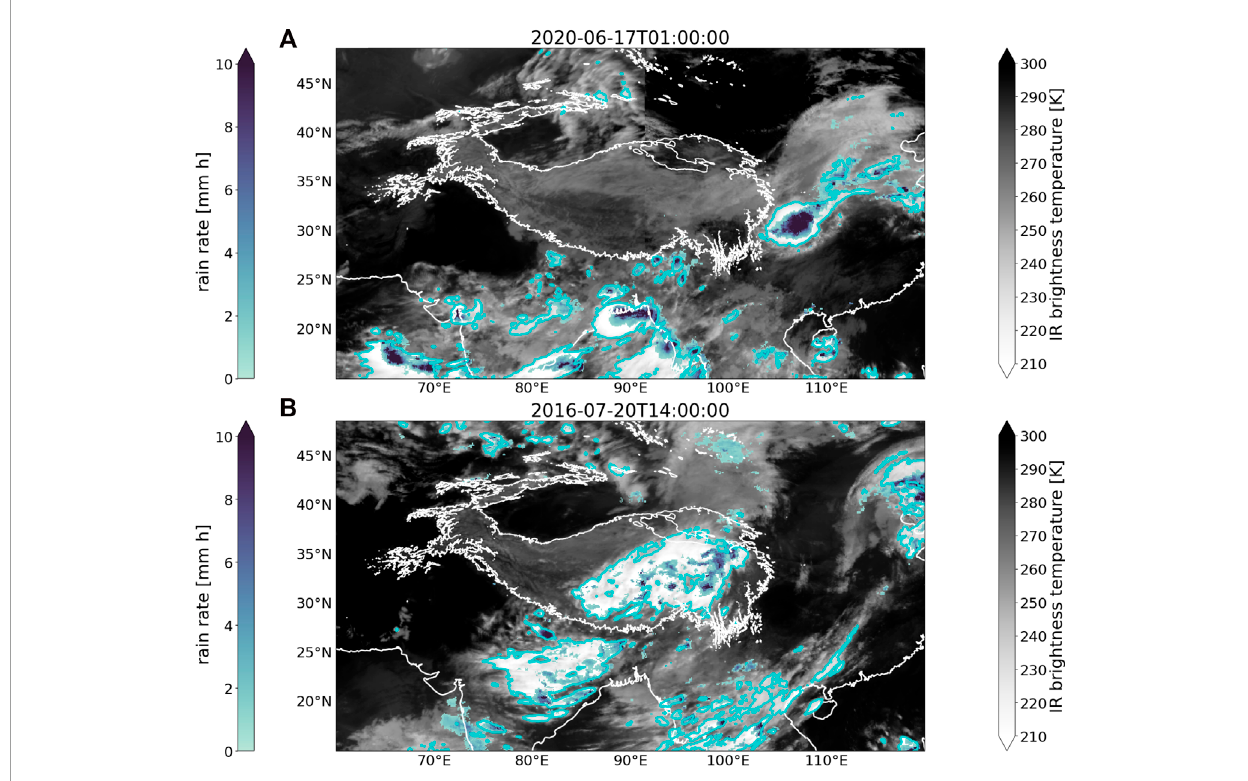
FIGURE 1 Two example snapshots of hourly IR brightness temperatures overlaid with hourly precipitation estimates from GPM IMERG. The turquoise lines indicate the 241 K contour, a commonly used threshold to define the cloud area of an MCS. (A) shows an MCS that occurred at the downwind side of the TP in June 2020. (B) shows an MCS that formed over the TP. The white contour line over land is the 3000 m elevation contour of the